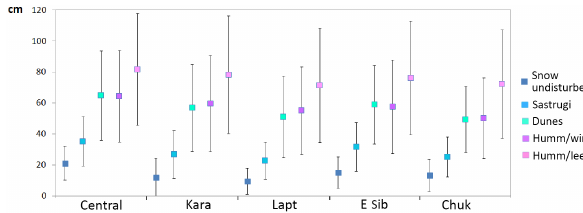
Figure 14. Sever snow depth observation statistics in the MAM months: depth of undisturbed snow on the level ice, snow depth of sastrugi, snow depth of dunes extending out from ice ridges, depth of snow on windward and leeward sides of the hummock and cor- responding standard deviations. Data shown are averages for the central Arctic and for the four seas: Kara, Laptev, East Siberian and